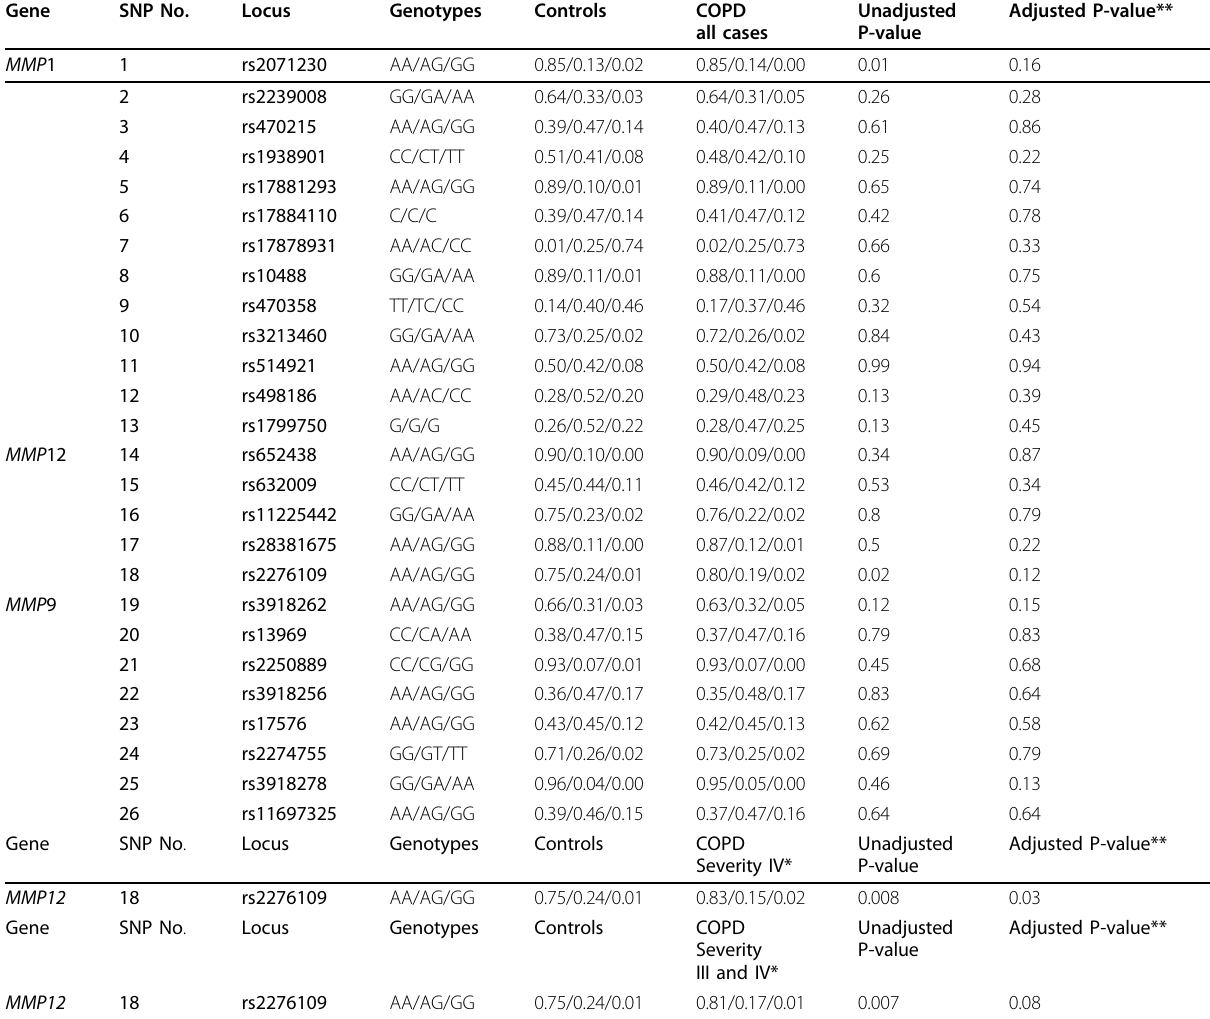
Table 5 MMP s - 1, 12 and 9 - Genotype frequencies in Controls and Cases Gene SNP No. Locus Genotypes Controls COPD